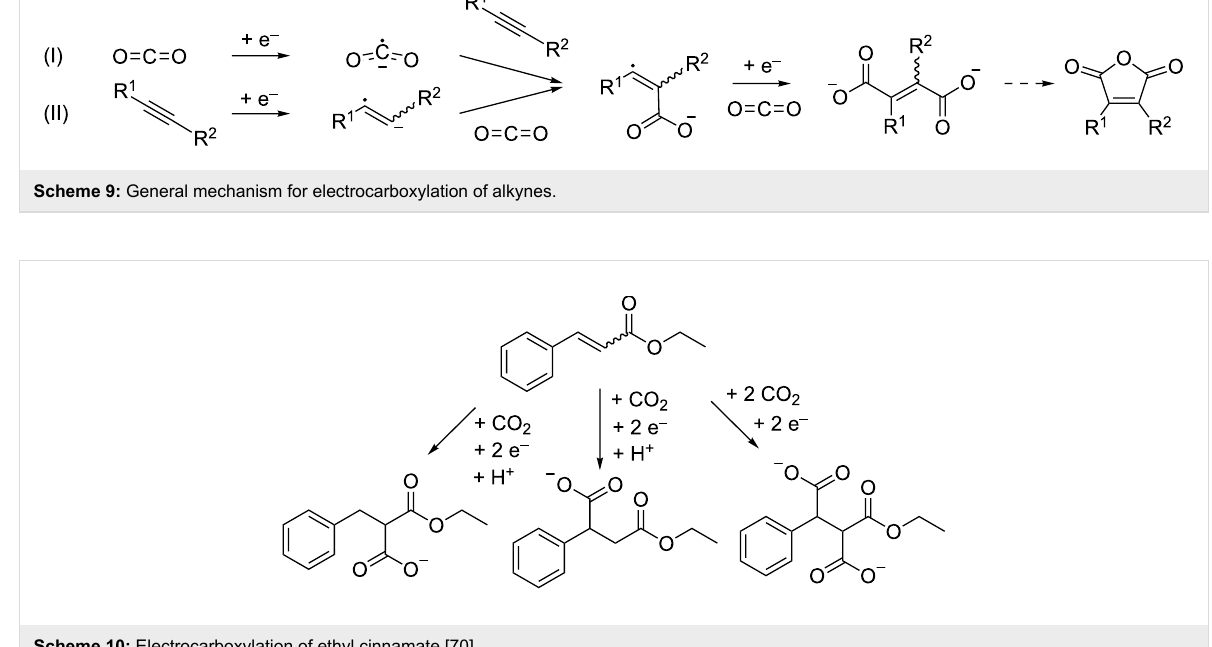
Scheme 10: Electrocarboxylation of ethyl cinnamate